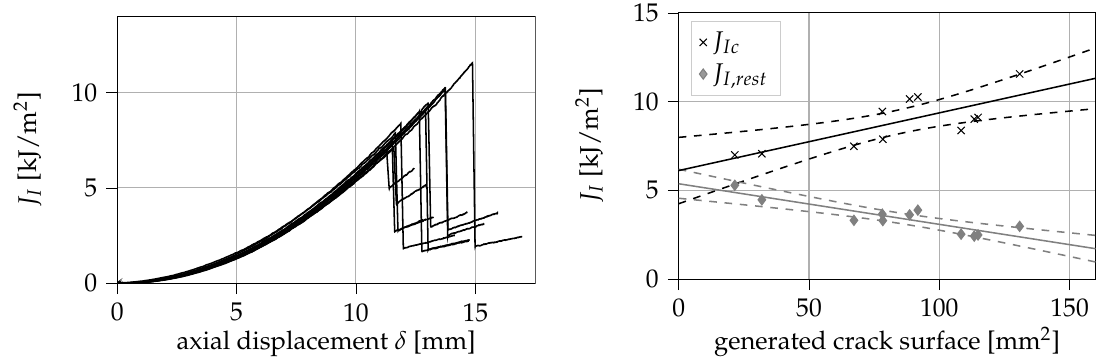
Figure 9. Measured values of the mode I J -integral ( left ) and obtained values for J Ic and J I ,rest over the generated crack surface ( right